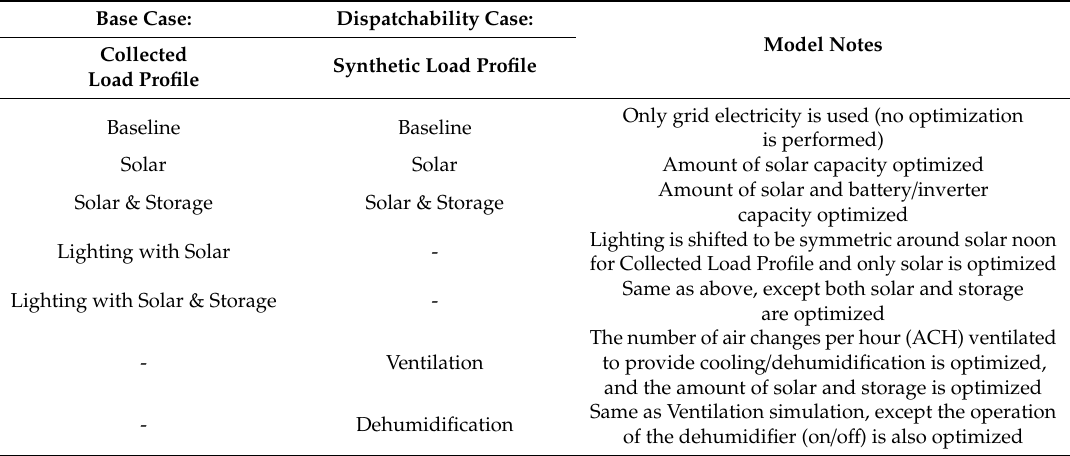
Table 2. Outline of model simulations performed for the two cases studied: Base Case, using load data collected from an operating containers farm; and Dispatchability Case, using a synthetic load profile based on optimization of dispatchable loads with demand-side management